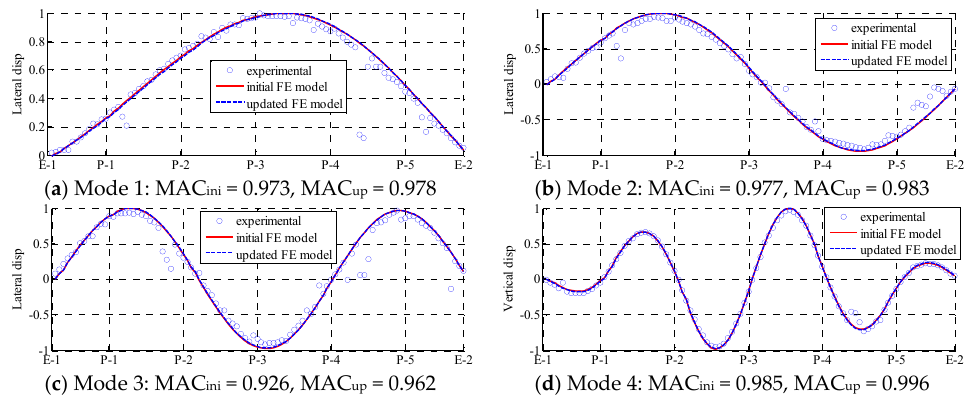
experimental initial FE model updated FE model